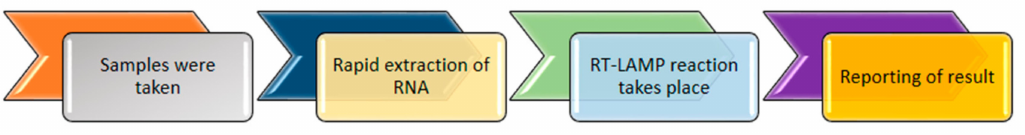
Figure 12. Working mechanism of the RT-LAMP